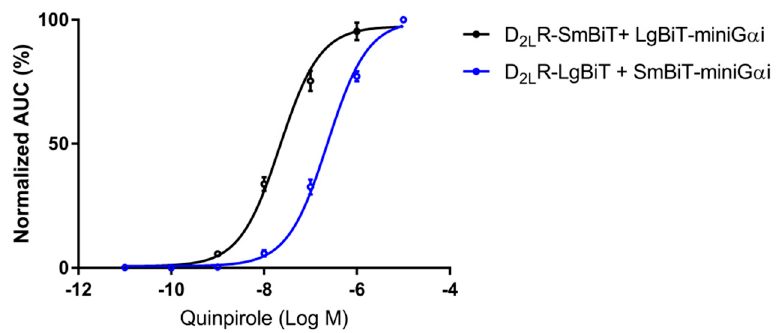
Figure 1. Real-time monitoring of mini-G α i protein recruitment to the D 2L R by the NanoLuciferase Binary Technology (NanoBiT) assay. Transient overexpression of fusion constructs of the LgBiT and SmBiT of NanoLuciferase C-terminal to D 2L R and N-terminal to the mini-G ai -protein was achieved in HEK293T cells. Luminescence was monitored for 2 h. Concentration-response curves were generated by the addition of quinpirole (0.01 nM–10 µ M), and the corresponding AUCs (four independent experiments, in triplicate) normalized and plotted to the logarithmic concentration of quinpirole ( n = 12, ±